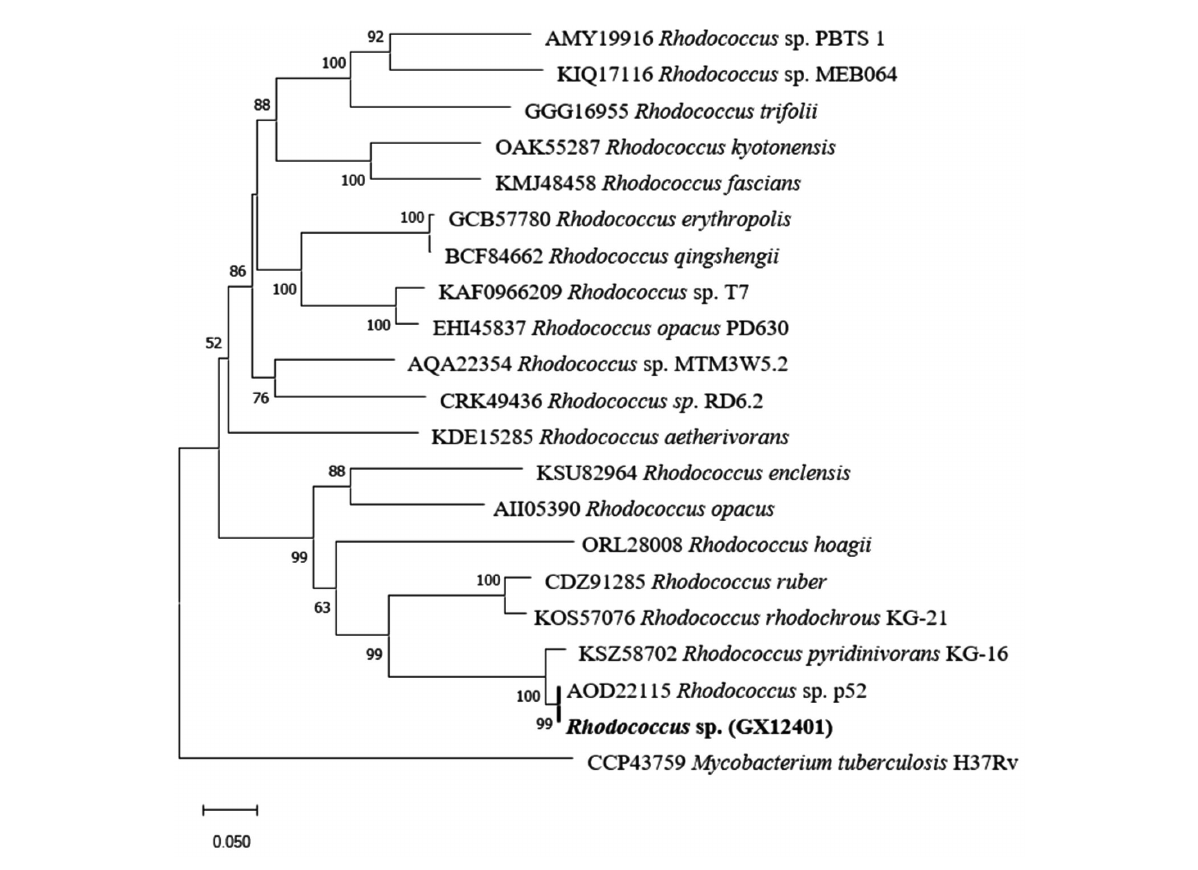
FIGURE 2 The Neighbor-joining (NJ) tree based on the Rhodococcus rpfB gene sequences showing the phylogenetic relationship of strain Rhodococcus sp. (GX12401) with related taxa. The tree was rooted by the mid-point method. The sequence of M. tuberculosis H37Rv (CCP43759.1) was used as an outgroup. Bootstrap support values were calculated from 1,000 replicates and only values above 50% are shown. Bar, 0.05 substitutions per nucleotide